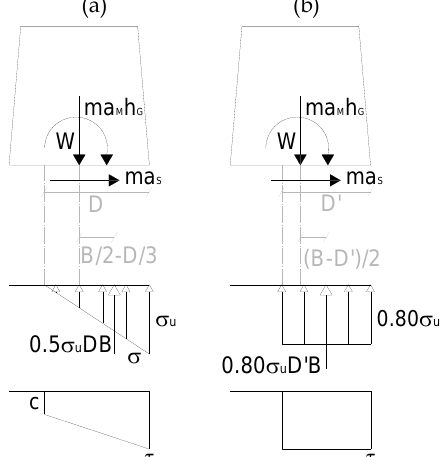
Figure 4. Equilibrium of the base section for the second approach, corresponding to the onset of the yielding (a) and to the collapse